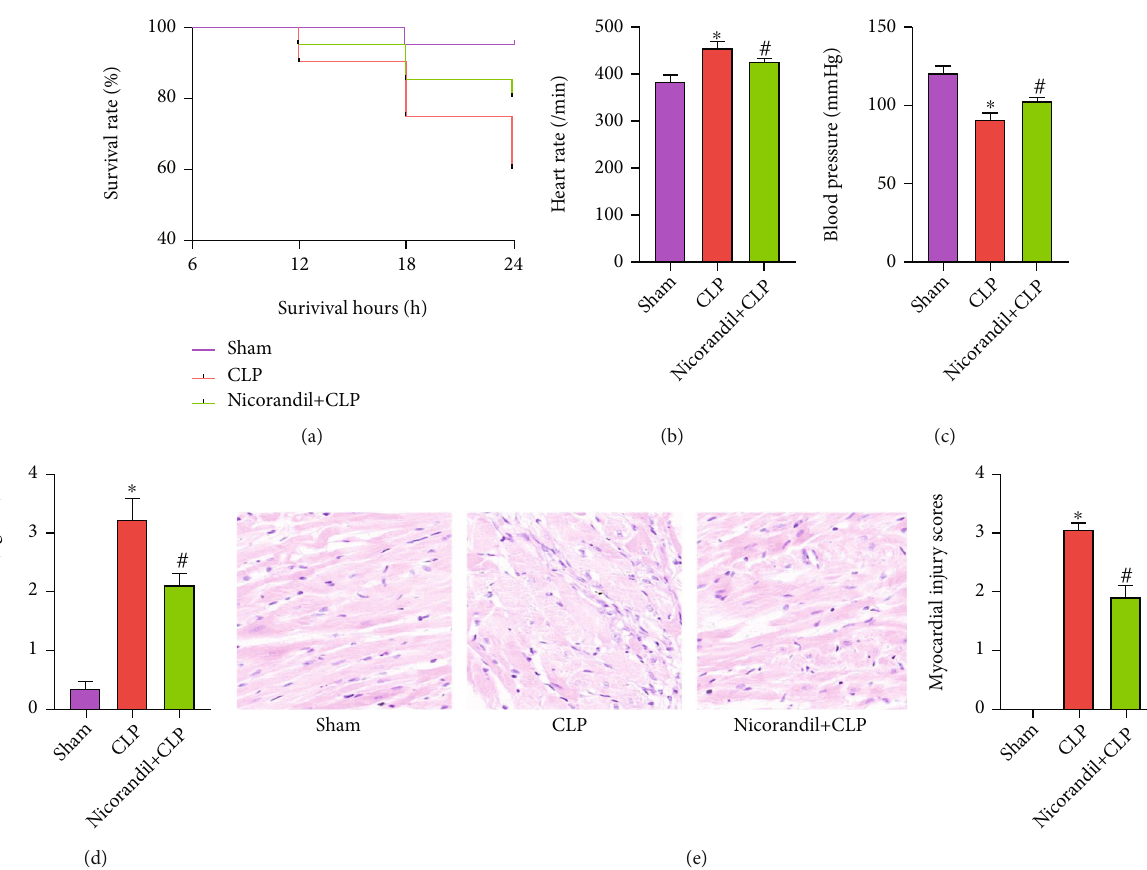
Figure 1: Nicorandil improves the survival rate and heart function of rats with septic cardiomyopathy. (a) The survival rate of rats in all three groups was 24 hours after CLP. (b) Heart rate was detected 24 hours after modeling in three groups of rats. (c) Blood pressure was detected 24 hours after modeling in three groups of rats. (d) The levels of cTnI in serum of three groups of rats. (e) H&E staining of heart tissues in three groups of rats and histological injury scoring system of myocardium. “ ∗ ” P < 0 : 05 vs. sham group; “ # ” P < 0 : 05 vs. CLP